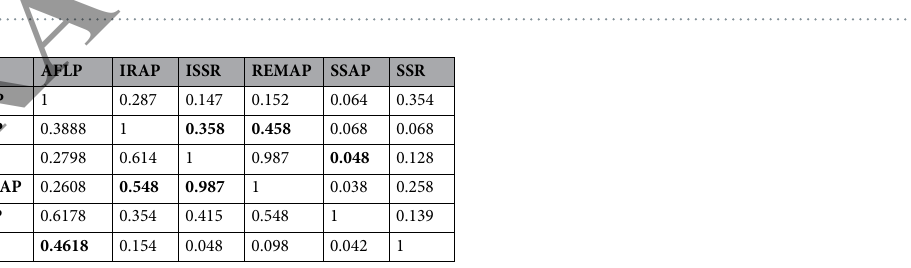
Table 5. Correlations between cophenetic matrices (above diagonal) and similarity matrices (below diagonal) obtained with different markers systems. Bold typeset indicates statistically significant ( P ≤ 0.05) values.